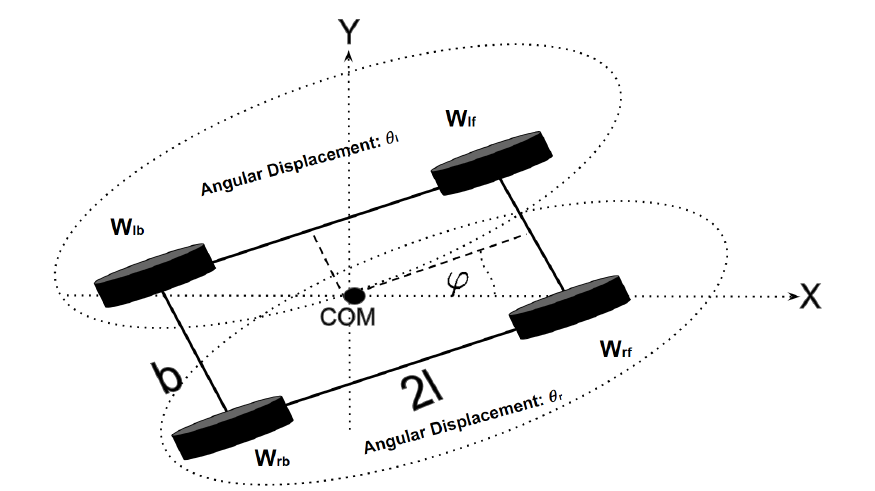
Figure A1. Schematic of the base of